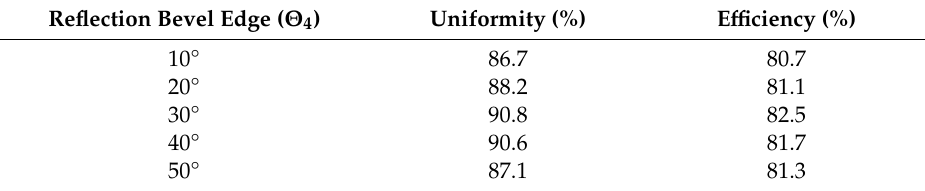
Table 5. Efficiency and uniformity of calculation results at various bevel angles 𝚯 𝟒 . Reflection Bevel Edge ( 𝚯 𝟒 ) Uniformity (%)